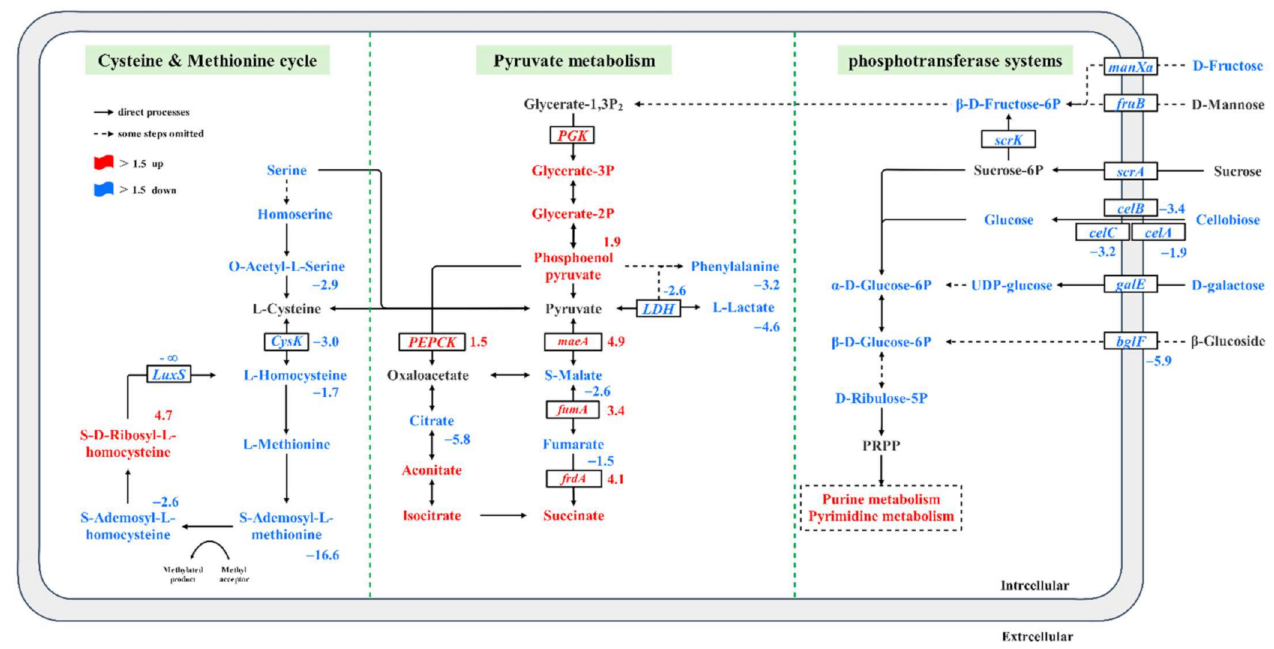
Figure 6. Changes of the expression levels of genes and metabolisms involved in L. plantarum ( ∆ luxS /SS-128 vs. SS-128). Pathways were constructed based on information provided in the KEGG database and previous studies. Microcompartments are depicted by dotted green